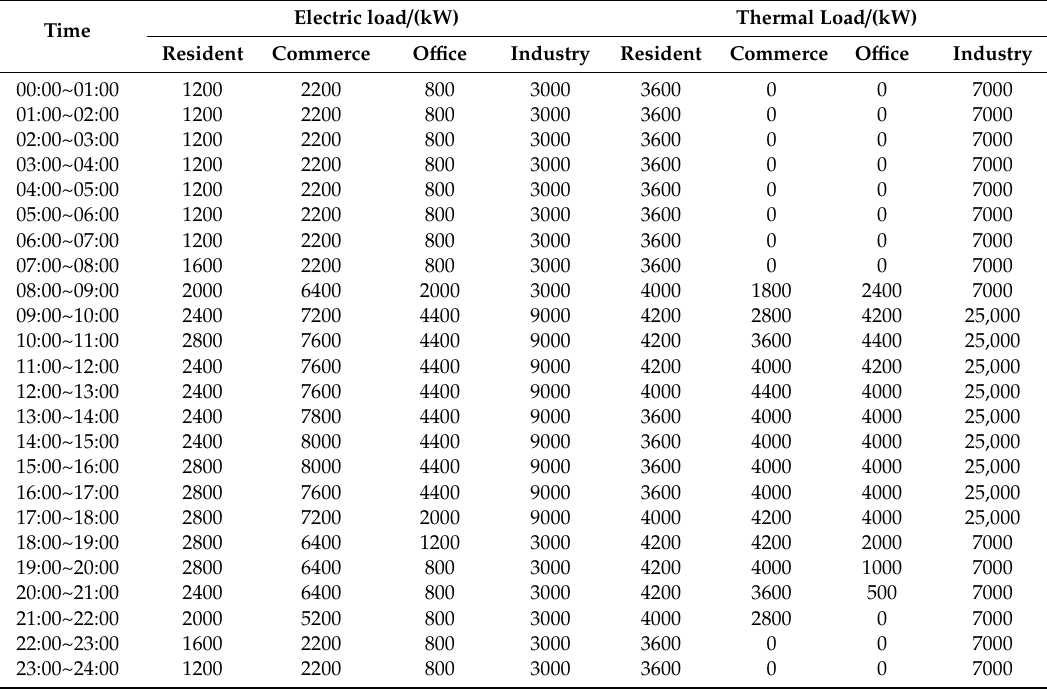
Table A3. Electric and thermal load.